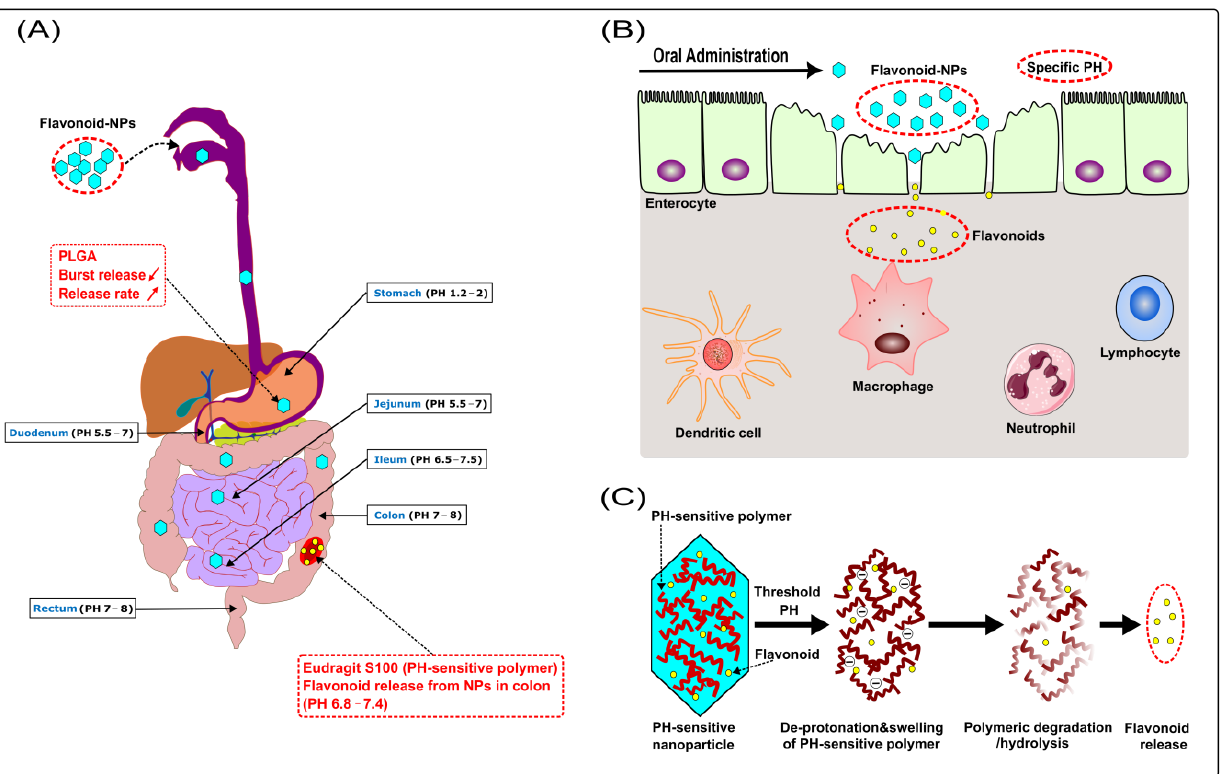
Figure 6. ( A ) PLGA (a biodegradable polymer) reduces the burst release of NPs, whose release rate is also prolonged; Eudragit S100 (a pH-sensitive polymer) protects NPs from destruction in the stomach and small intestine, then releases the flavonoid in the colon (pH ≥ 6.8). ( B ) Disturbed mucosal barrier, loss of epithelial integrity, widening of gaps between enterocytes, and increased recruitment of immune cells are usually present in IBD. The pathological changes disrupt the barrier function of the epithelium with increased translocation of bacteria and loss of fluid and electrolytes. Meanwhile, they facilitate increased accumulation and penetration of NPs across the epithelium and uptake by enterocytes and immune cells such as macrophages. ( C ) Mechanism of flavonoid release from pH-sensitive NPs: Eudragit S100 (a pH-sensitive polymer) deprotonates when exposed to a threshold pH ≥ 6.8, causing polymer swelling, dissolution, and erosion with subsequent flavonoid release. ( decrease;